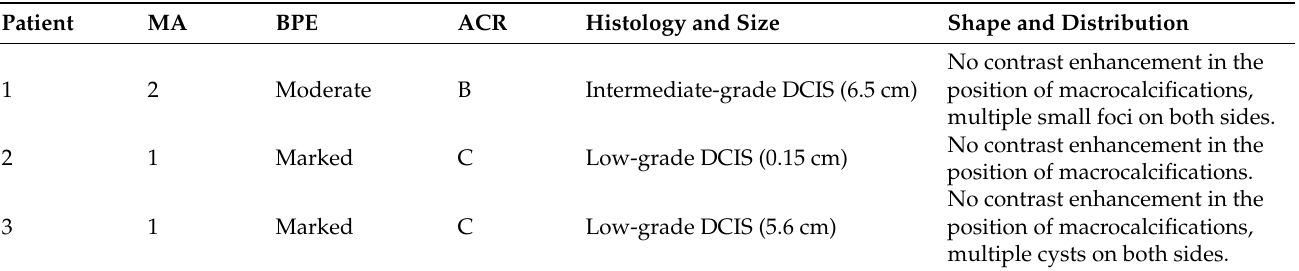
Table 3. False negative findings in the combined analysis of mammography (MG) and breast magnetic resonance imaging